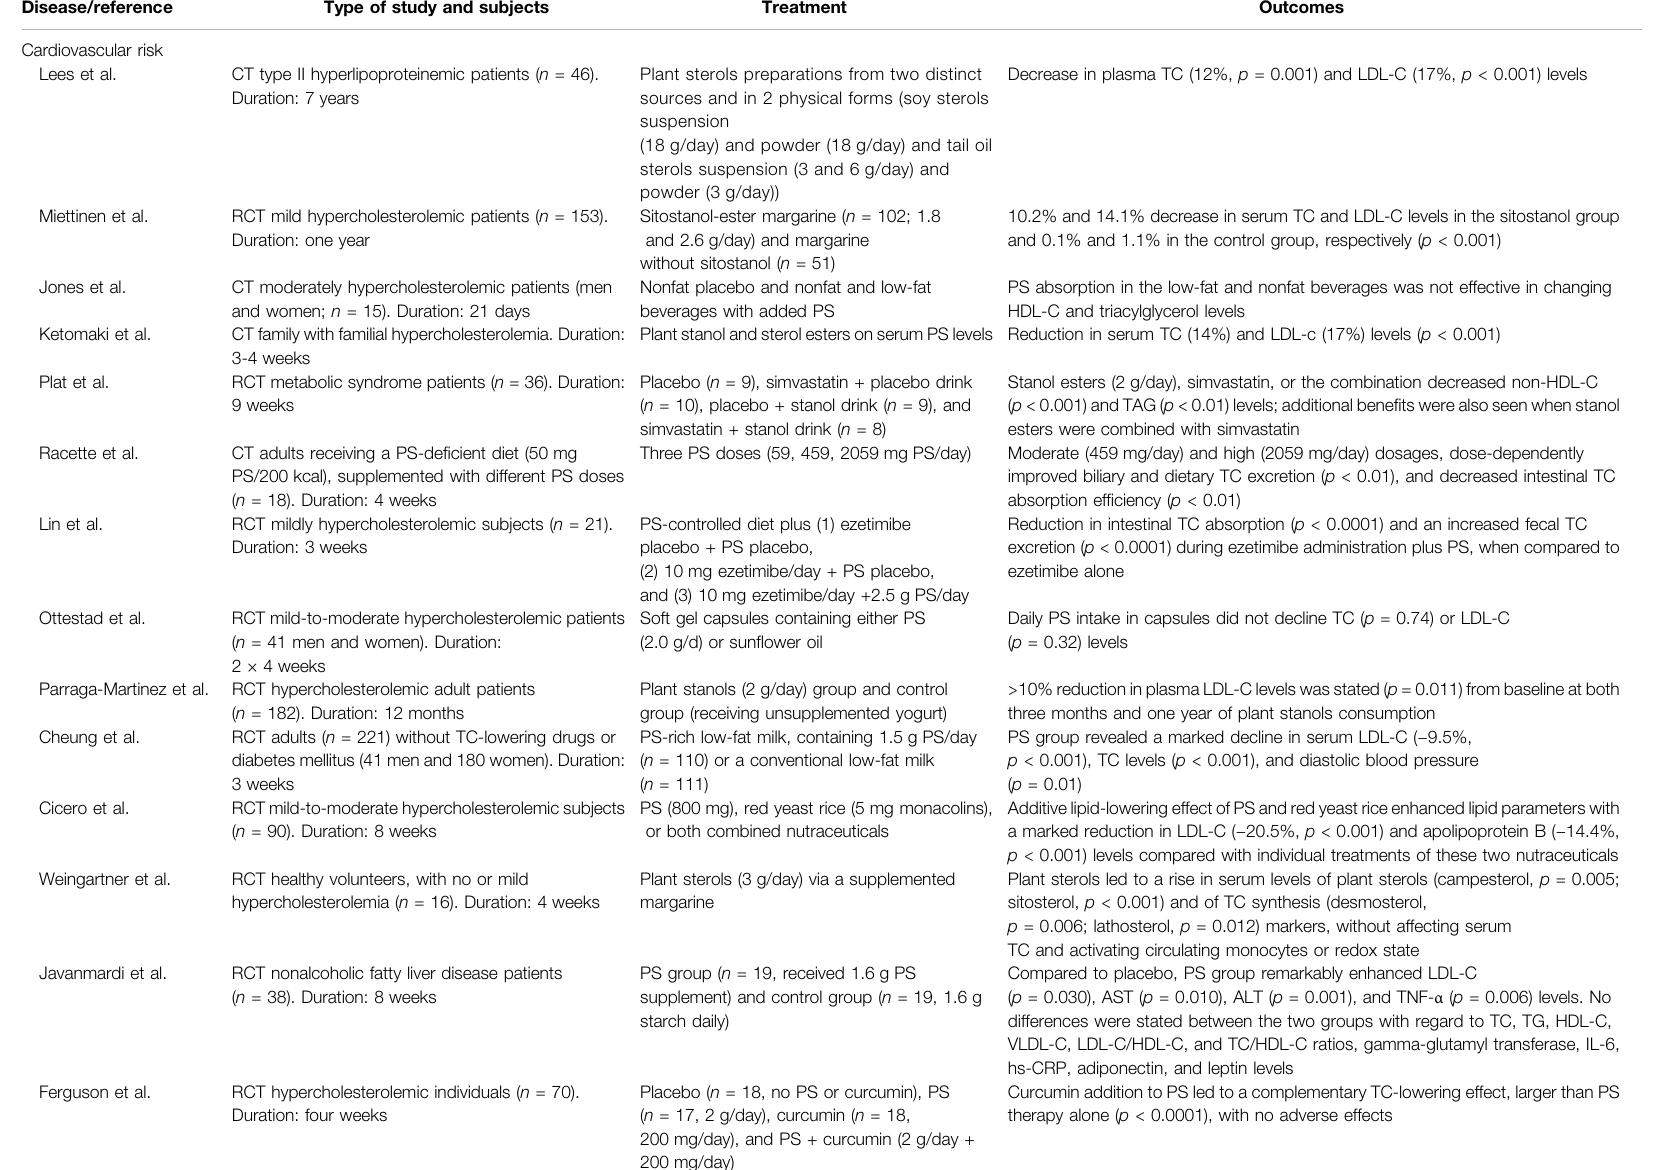
TABLE 2 | Clinical studies with PS effects in humans.